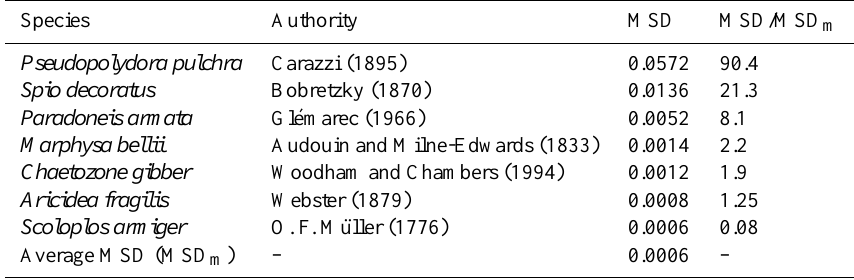
Table 5. Mean square drift (MSD) for the most abundant species of polychaetes in PN station. The third column is the normalised coefficient.